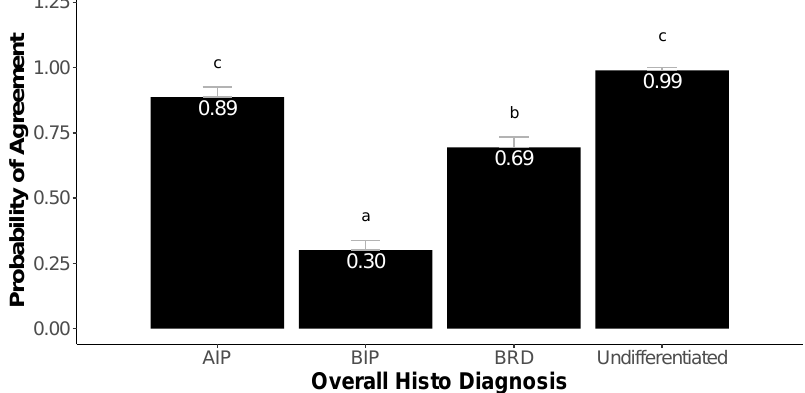
Figure 6. Probability of agreement between histopathological sample (HistoSp) diagnosis with overall case diagnosis (HistoDx) from feedyard necropsies on 172 cases. Results generated from generalized linear model with random effects for individual feedyard ( n = 6) and case number (4 HistoSp per case). Differing superscript letters illustrate statistical differences (p < 0.05) in probability of agreement among HistoDx.